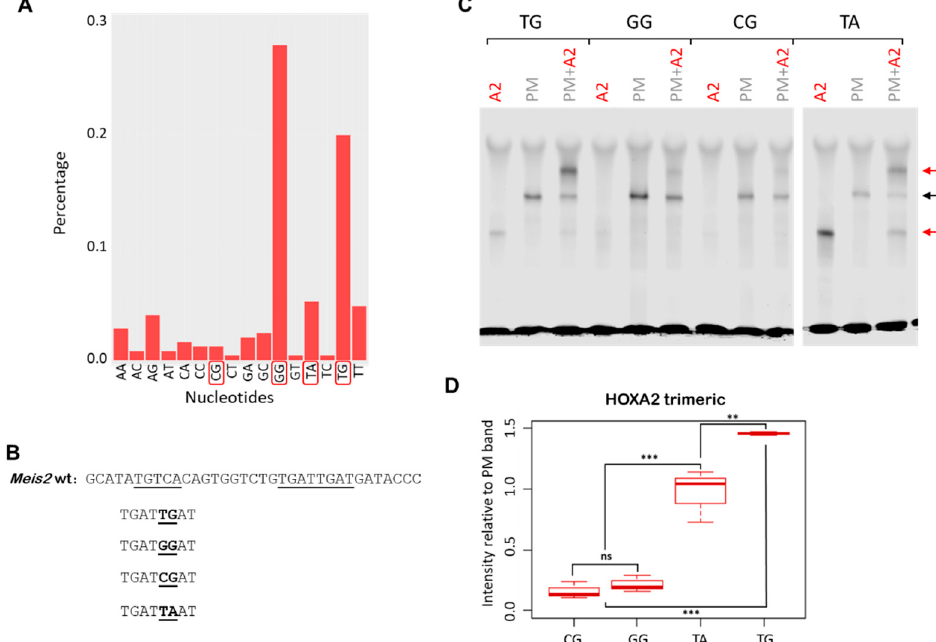
Figure 1. HOX binding affinity for in vivo bound HOX-PBX sites. ( A ) Percentage of TGATNNAT variants (all possible permutations of the NN variable region) in top 250 HOXA2 peaks, ranked by fold enrichment. ( B ) Reverse complement section of the Meis2 probe sequence containing HOX-PBX and MEIS motifs, underlined, and the mutant sequences with the relevant substitutions in bold (wild-type sequence is TGATTGAT). ( C ) HOXA2 binding to the Meis2 probes containing mutations detailed in ( B ), in the presence and absence of PBX/MEIS (PM). Trimeric complex binding is reduced in all mutants, but TA mutant sees an increase in the binding of monomeric HOXA2. Black arrows indicate PBX/MEIS dimer, red arrows indicate HOXA2 interactions with the probe. ( D ) The quantification of HOXA2/PBX/MEIS bands from experiment in ( C ) (three replicates) shows a reduction in all mutants relative to the wild type. All bands are quantified relative to the wild-type PBX/MEIS band. ** p -value < 0.005; *** p -value < 0.0005; ns: no